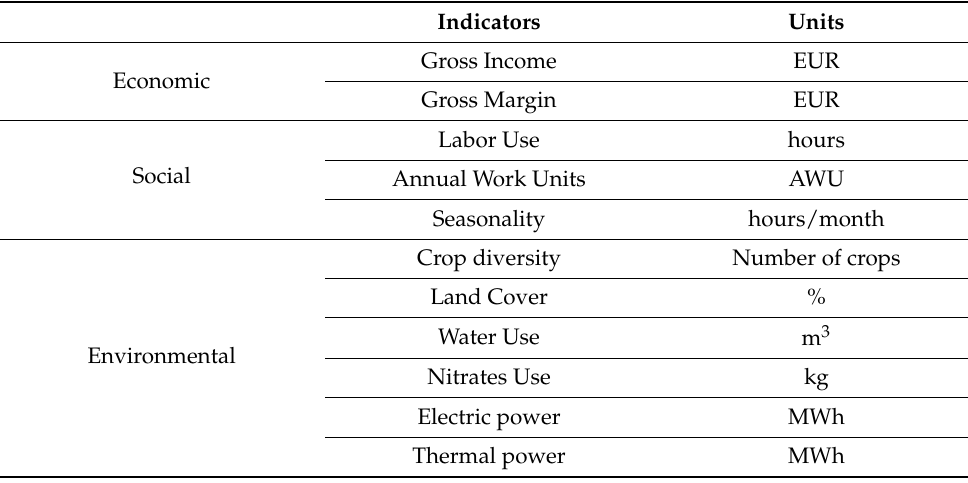
Table 1. Selected Economic, Social and Environmental